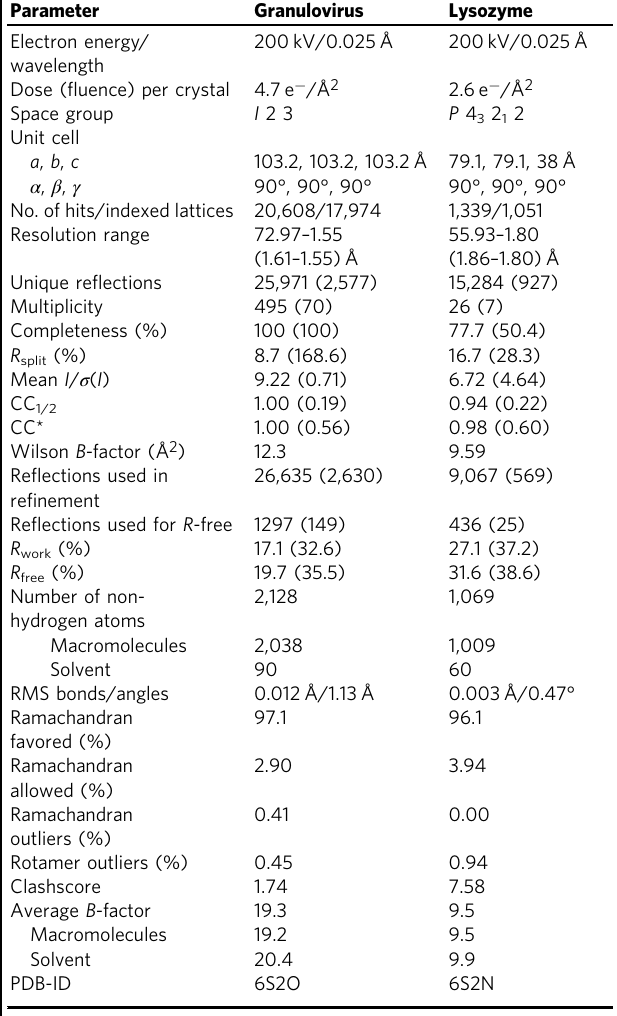
Table 1 Data collection and re fi nement statistics.